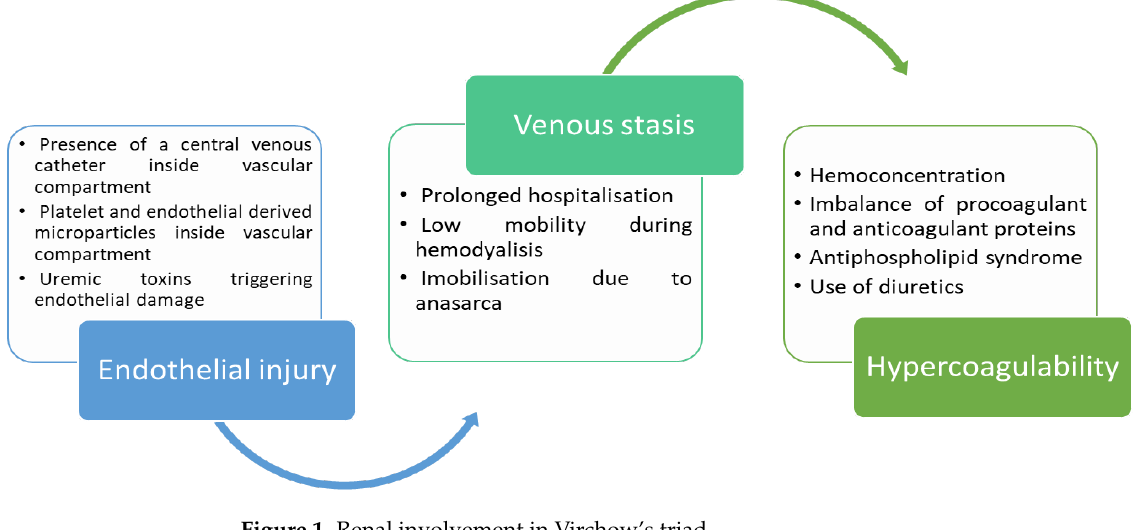
Figure 1. Renal involvement in Virchow’s triad. Table 1. Relevant studies depicting the children risk for VTE.